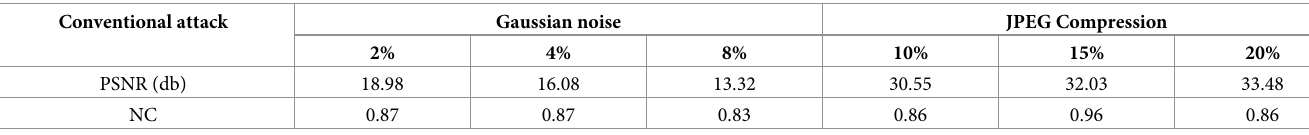
Table 2. Dct and SURF ON conventional